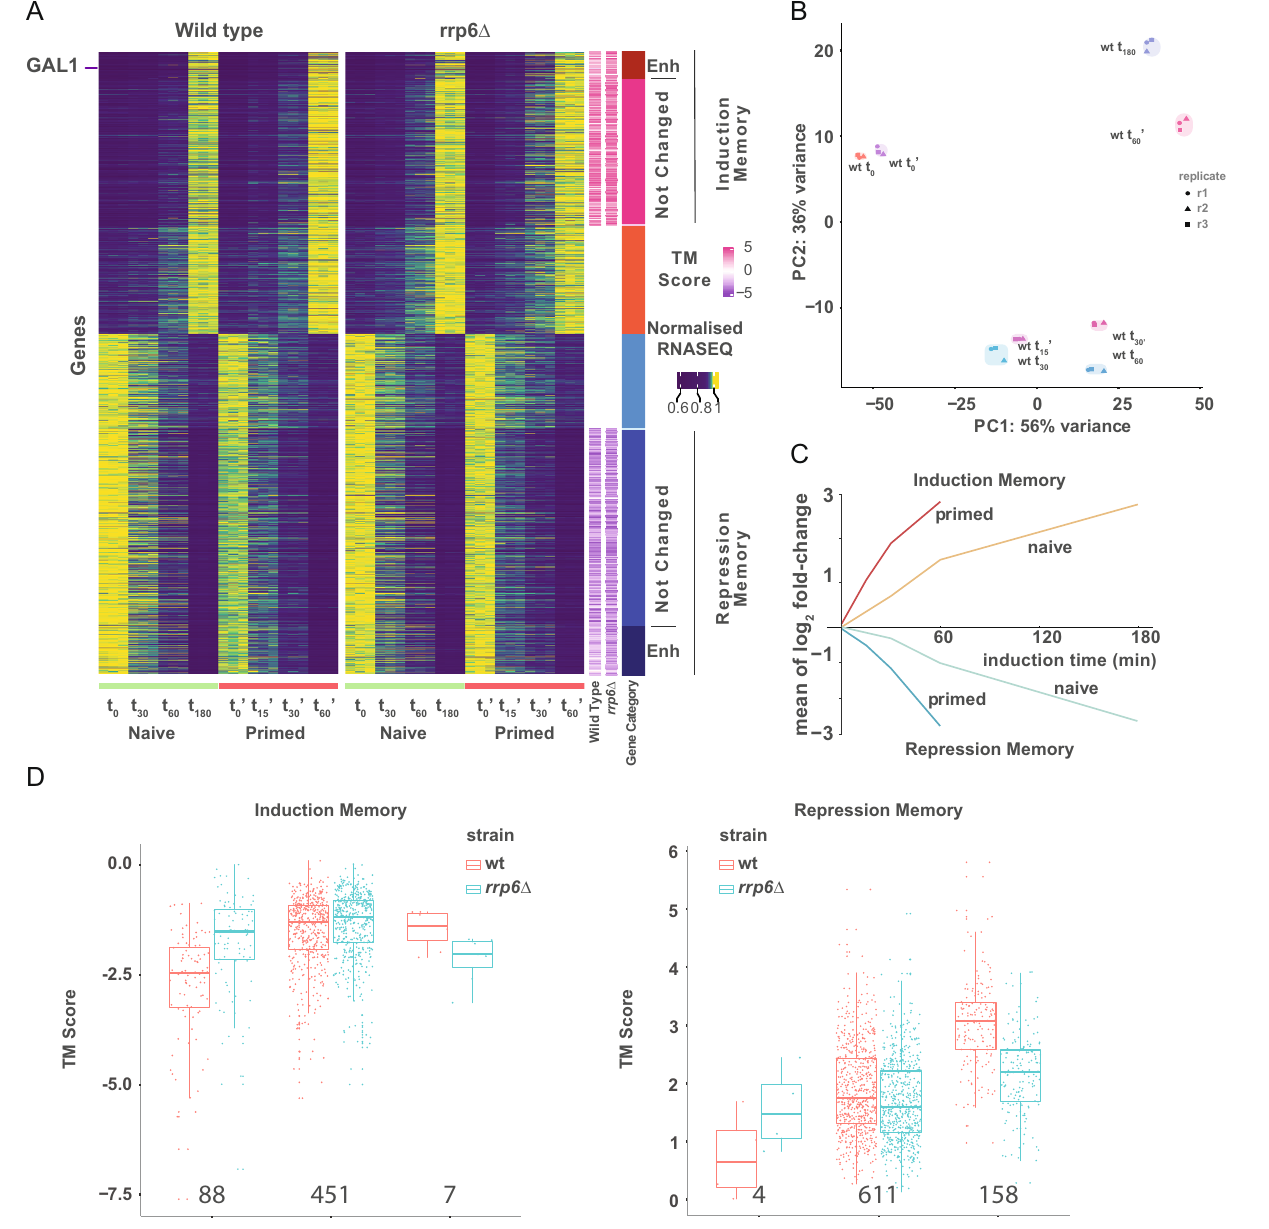
Fig. 2 | Genome-wide identi fi cation of genes with transcriptional memory. A Heatmap of variable genes in RNA-Seq of both wild type and rrp6 Δ strains. Heatmap intensity represents relative mRNA abundance for each replicate at dif- ferenttimepoints.GeneintensityisnormalizedbythemaximummRNAabundance across all time points. Gene-speci fi c transcription memory score (TM score : log 2 fold-